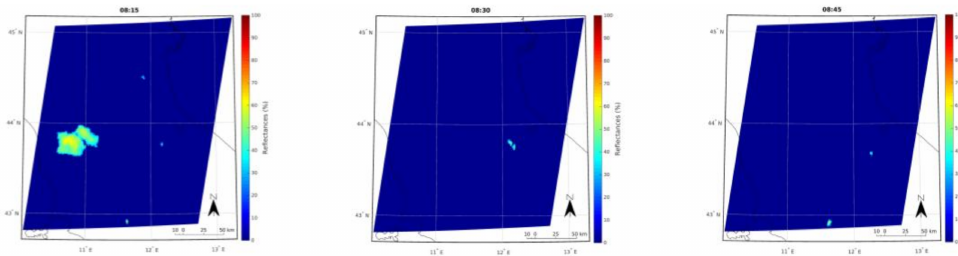
Figure 11. Fog temporal evolution detected by SatFog algorithm on 2017-04-10 between 06:45 and 08:30 UTC. Zoom on the fog